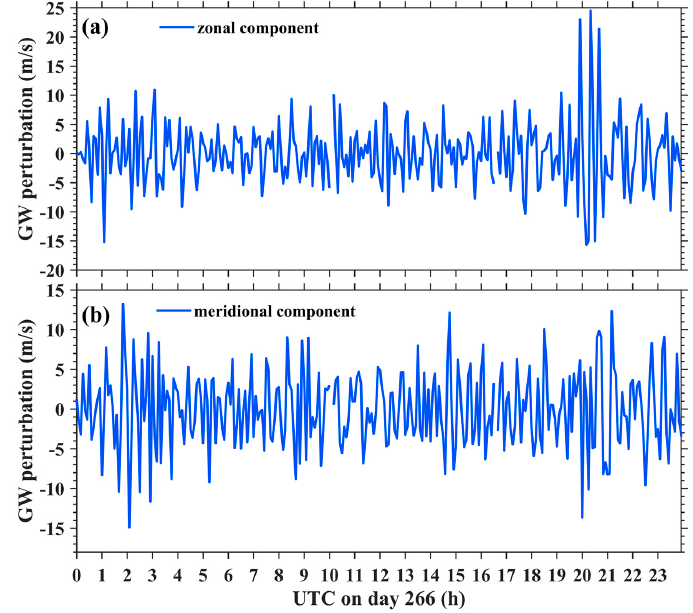
Figure 6. ( a ) Zonal wind velocity perturbation caused by GW (blue line) on day 266 in 2013. Similarly, ( b ) indicates the result for the meridional component.